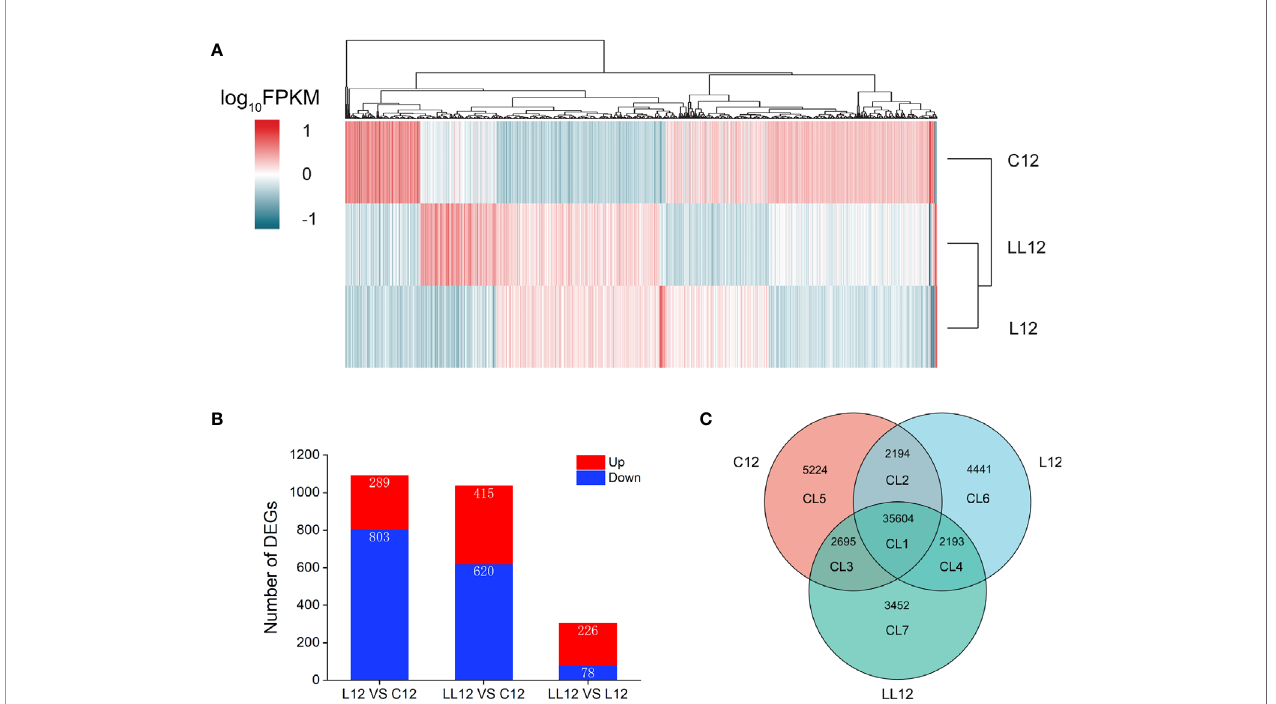
FIGURE 3 | Overview of the expression analysis for C12, L12 and LL12. (A) Hierarchical clustering heat map constructed based on DEGs. Each row represents a group, each column represents a DEG. The expression level of each DEG is shown as the log 10 (FPKM) value. Red and blue gradients indicate increased and decreased transcript abundance, respectively. (B) Number of DEGs in the different groups. (C) Venn diagram showing the number of commonly and uniquely expressed genes among different